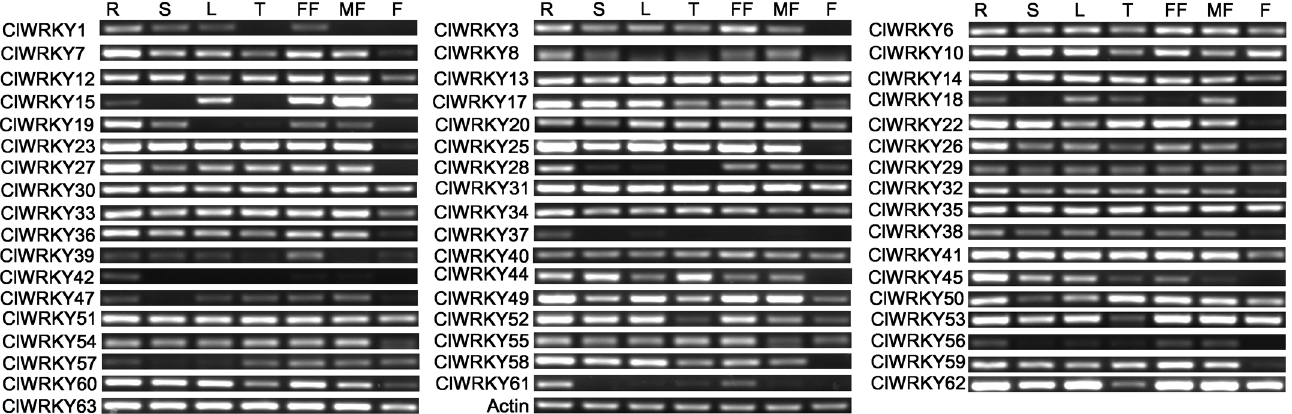
Fig 7. Expression profiles of ClWRKY genes in various tissues of ‘Y34’ by semi-quantitative RT-PCR analyses. β -actin gene was used as the internal control. Six amplified bands from left to right for each WRKY gene represent amplified products from R: root; S: stem; L: leaf; T: tendril; FF: female flower; MF: male flower and F: